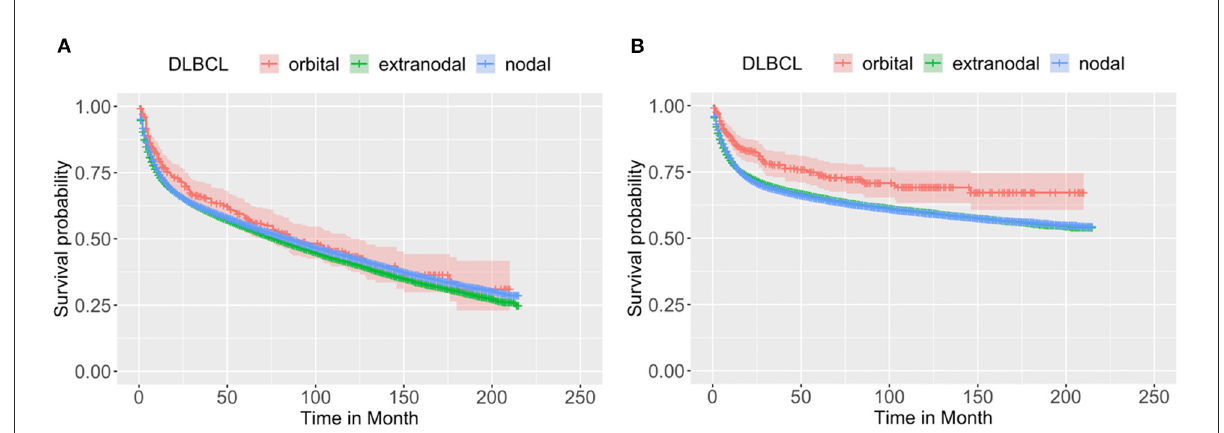
FIGURE1 The Kaplan–Meier survival curve of (A) OS and (B) CSS of patients with DLBCL by the primary sites: orbit ( n = 332), other extra-nodal sites ( n = 32,728), and nodal site ( n = 64,547). Through log-rank test, it was revealed that the OS and CSS were not identical among the three groups, with a p < 0.0001 and 0.0012, respectively, indicating the primary sites may affect the survival of DLBCL